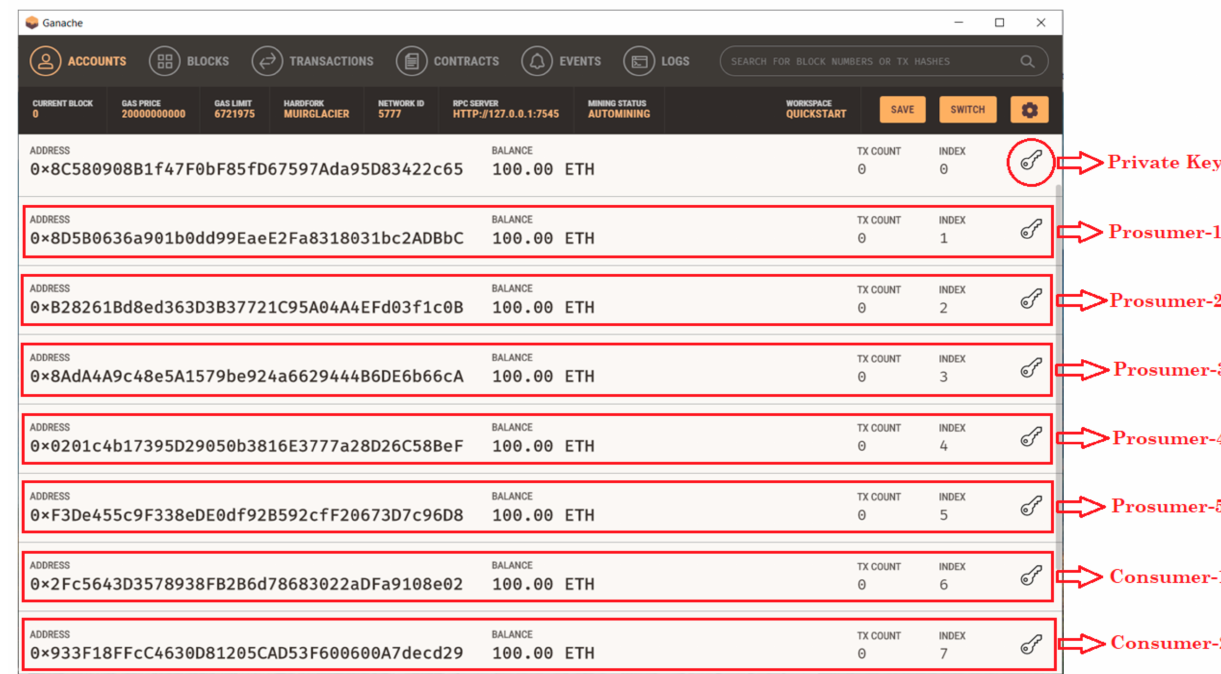
Figure 8. Ganache